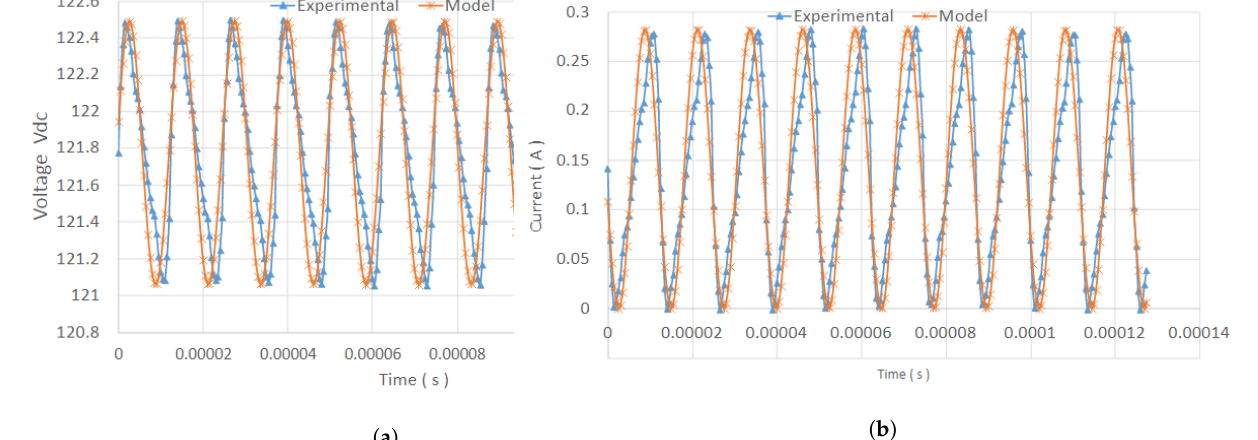
Figure 19. Experimental and theoretical data of the LED lamp. ( a ) Voltage waveform. ( b ) Current